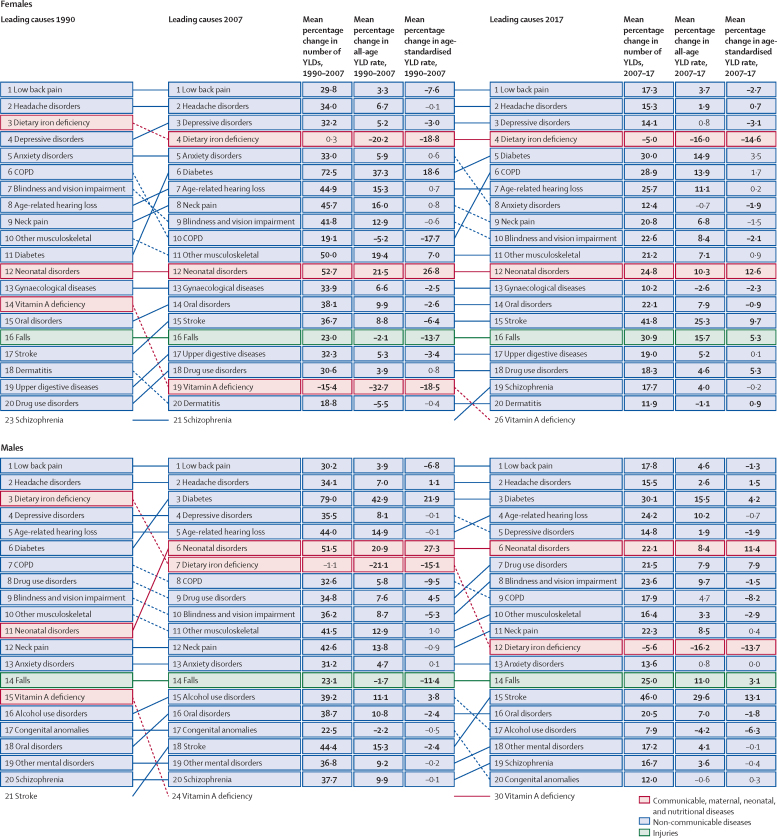
Leading 20 Level 3 causes of global YLDs for 1990, 2007, and 2017, with percentage change in number of YLDs and all age and age-standardised rates for each sexCauses are connected by lines between time periods; solid lines are increases and dashed lines are decreases. For the time periods 1990–2007 and 2007–17, three measures of change are shown: percentage change in the number of YLDs, percentage change in the all-age YLD rate, and percentage change in the age-standardised YLD rate. Communicable, maternal, neonatal, and nutritional diseases are shown in red; non-communicable causes in blue; and injuries in green. Statistically significant changes are shown in bold. COPD=chronic obstructive pulmonary disease. YLDs=years lived with disability.